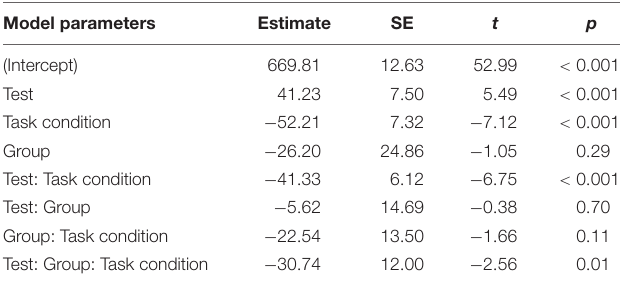
TABLE 10 | Model parameters for the best-fitting linear mixed effects model of the anti-saccade task in Experiment